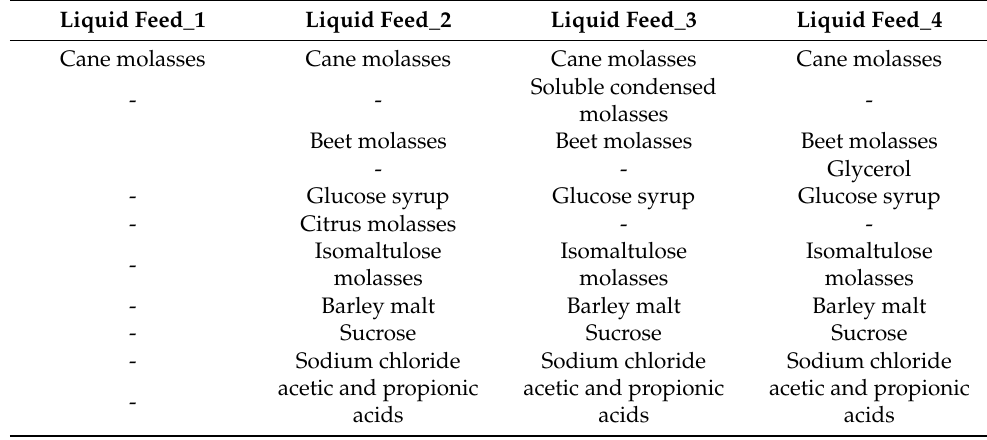
Table 1. Ingredients of four liquid feeds (Sugar Plus ®